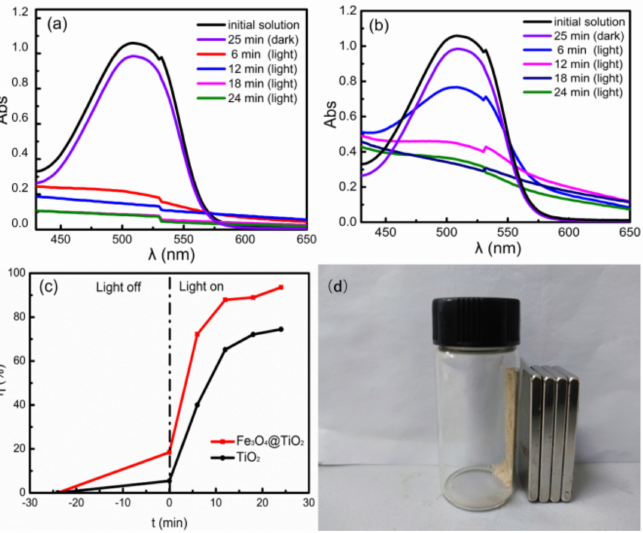
Figure 6. Photocatalytic degradation of AR73 by ( a ) Fe 3 O 4 @TiO 2 and ( b ) TiO 2 ; ( c ) the rate of degradation of AR73 by Fe 3 O 4 @TiO 2 and TiO 2 in a dark reaction time of 25 min and irradiation time of 24 min; ( d ) magnetically adsorbed Fe 3 O 4 @TiO 2